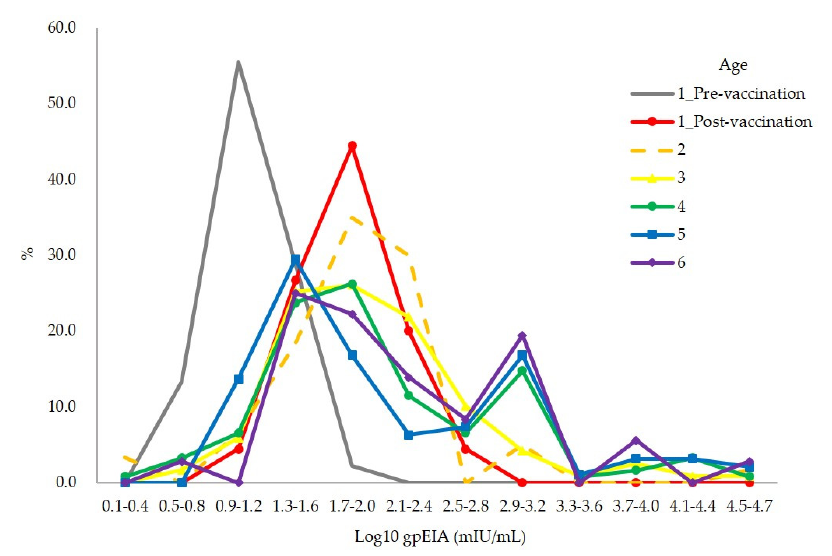
Figure 2. Distribution of gpEIA antibody titers in 477 children who were vaccinated without vari- cella history.